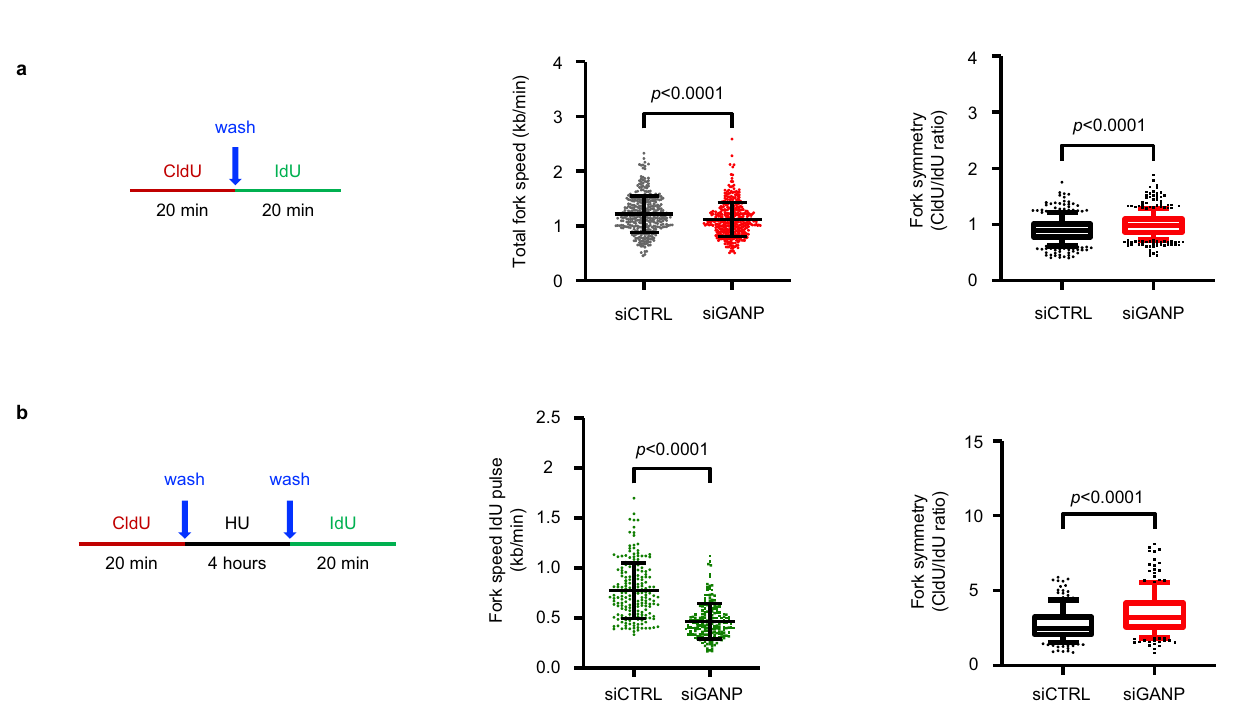
Fig. 5 GANP-depleted cells exhibit replication defects. a DNA fi ber analysis of the replication fork speed and symmetry in nontreated conditions. Left: schematic of the CldU/IdU pulse-labeling protocol used. Middle: analysis of the replication fork speed. Total number of molecules analyzed: siCTRL ( n = 362), siGANP ( n = 407). The plot includes the mean ± SD. Statistical test: unpaired t -test with Welch ’ s correction, two-tailed. Right: analysis of the replication fork symmetry. The ratio between CldU/IdU was calculated from the same molecules used for the analysis of the replication fork speed (middle) (siCTRL n = 362, siGANP n = 407). Bounds of box are 25th – 75th percentile, center shows the median, whiskers indicate the 10th – 90th percentiles, data outside the range are drawn as individual dots. Statistical analysis: unpaired t -test with Welch ’ s correction, two-tailed. b DNA fi ber analysis of the replication fork recovery upon HU removal. Left: schematic of the CldU/IdU pulse-labeling protocol used. Middle: length of the IdU tracks measured upon hydroxyurea removal. Total number of molecules analyzed: siCTRL ( n = 190), siGANP ( n = 181). The plot includes the mean ± SD. Statistical test: unpaired t -test with Welch ’ s correction, two-tailed. Right: analysis of the replication fork symmetry. The ratio between CldU/IdU was calculated from the same molecules used for the analysis of the length of the IdU tracks measured upon hydroxyurea removal (middle) (siCTRL n = 190, siGANP n = 181). Bounds of box are 25th – 75th percentile, center shows the median, whiskers indicate the 10th – 90th percentiles, data outside the range are drawn as individual dots. Statistical analysis: unpaired t -test with Welch ’ s correction, depletion does not impact the mRNA level of GANP (Supplementary Fig. 5f).